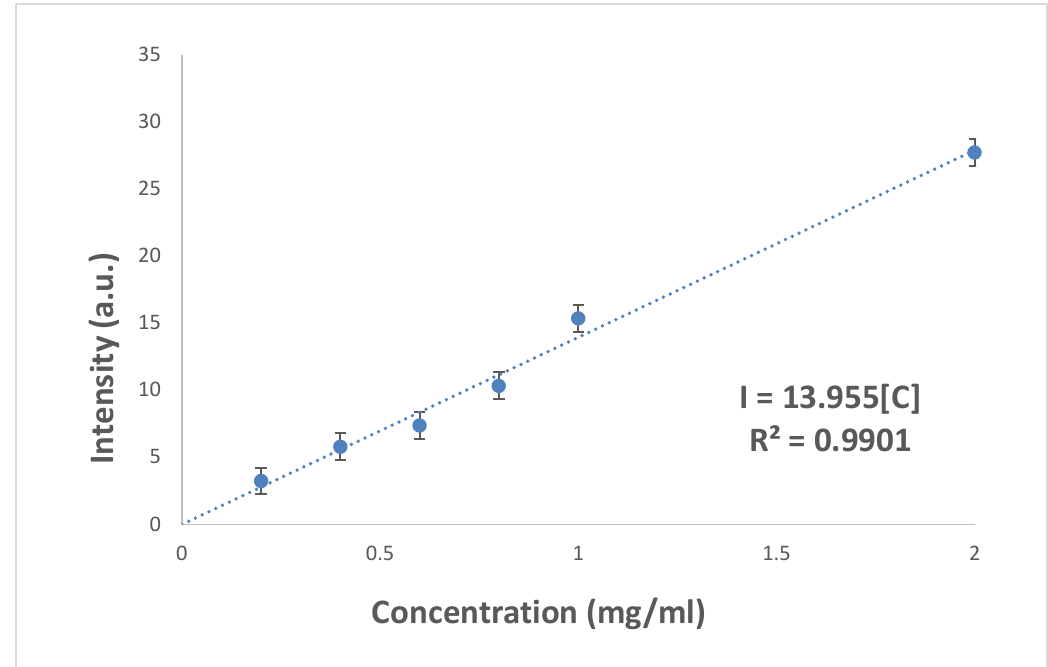
Figure 6. Calibration curve for amoxicillin drug release in PBS.